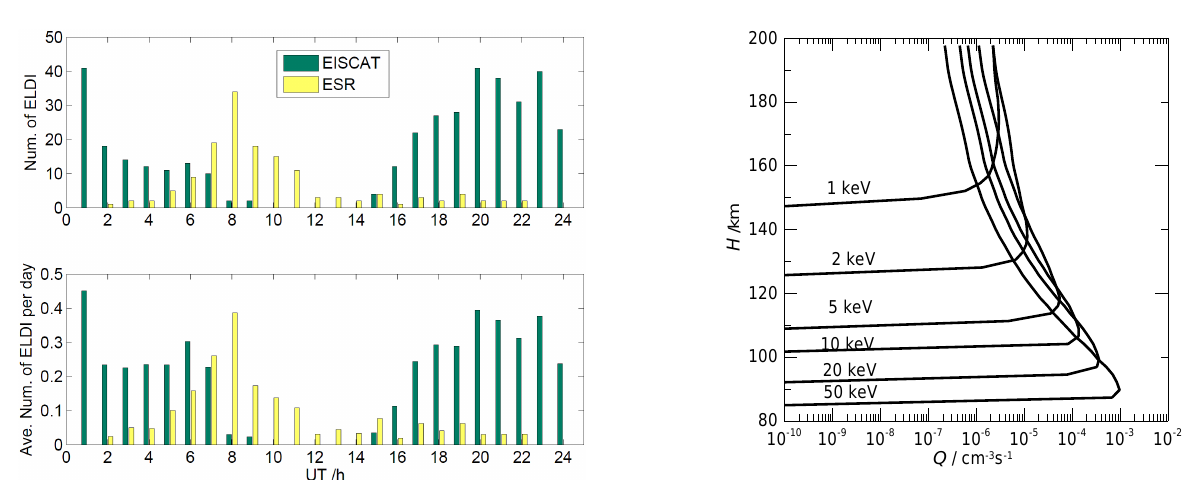
Figure 7. Diurnal variation of ELDIs observed by EISCAT/ESR radars (the top panel). In the bottom panel, numbers of ELDI were normalized according to observation as in Fig. 1c (LT ≈ UT + 1h, MLT ≈ UT + 3h).